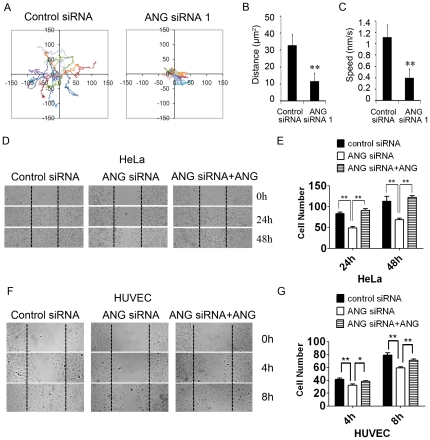
ANG deficiency attenuated cell migration.(A) HeLa cells were treated with ANG siRNA 1 or control siRNA. Movements of individual HeLa cells were traced by videomicroscopy. Migration tracks of 15 cells for each group are shown as scatter plots. The moving distance (B) and speed (C) of the tracked cells were calculated based on the data from each group provided by the ImageJ manual tracking plug-in. **P<0.01. HeLa cells (D) and HUVECs (F) were tranfected with ANG siRNA 1, treated with or without exogenous ANG, subjected to wound-healing assay, and then imaged at the indicated time. Cells transfected with control siRNA were used as control. Cells that migrated into the wound areas were counted and analyzed (E, G). Data shown are the mean ± SD of three independent experiments.